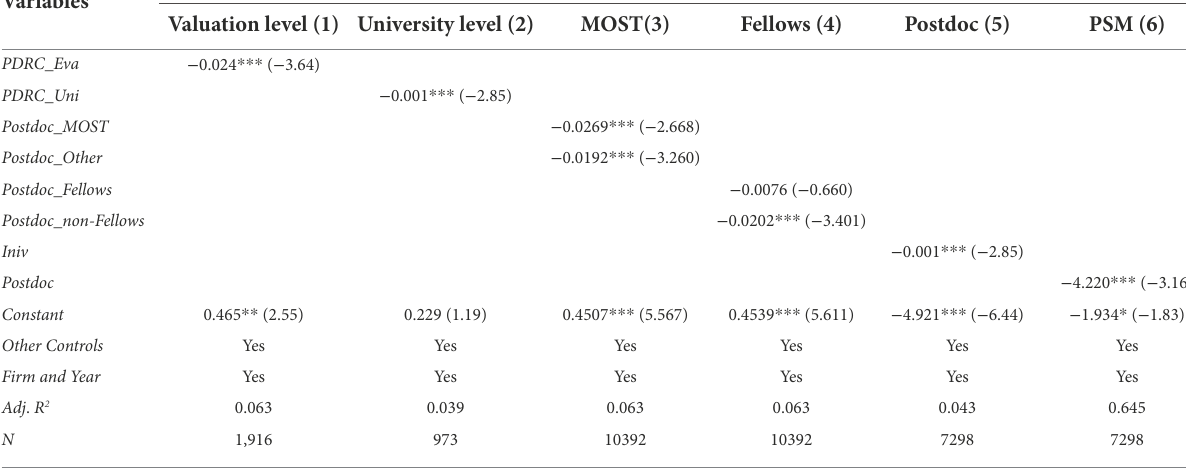
TABLE 6 The effect of the quality of postdoctoral workstation on LIE.